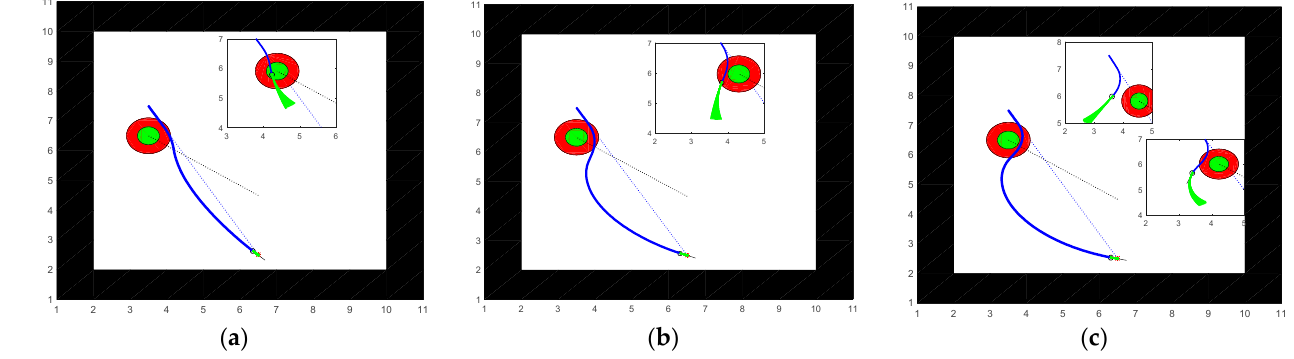
Figure 23. Comparison of path planning results for unknown dynamic environment 3; ( a ) Chi et al. [7]; ( b ) Improved algorithm [7]; and ( c ) This paper.